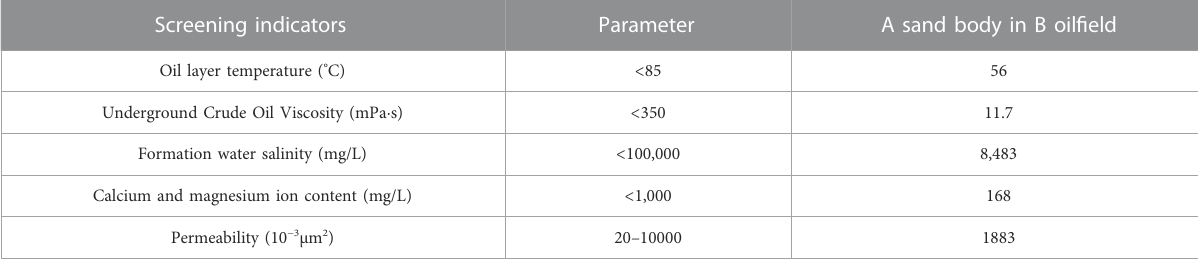
TABLE 2 Screening indicators of chemical fl ooding reservoirs in offshore oil fi elds.